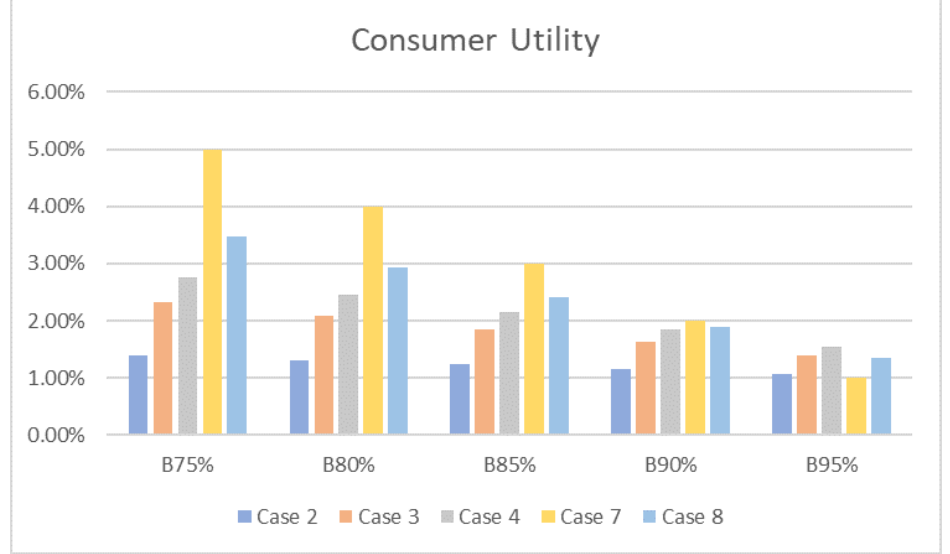
Figure 7. Comparative behavior in weighted scenarios: consumer